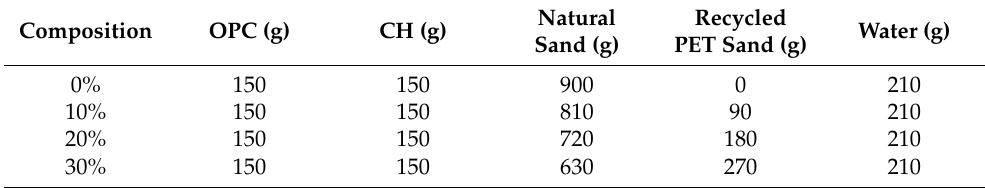
Table 1. Compositions studied in the research.